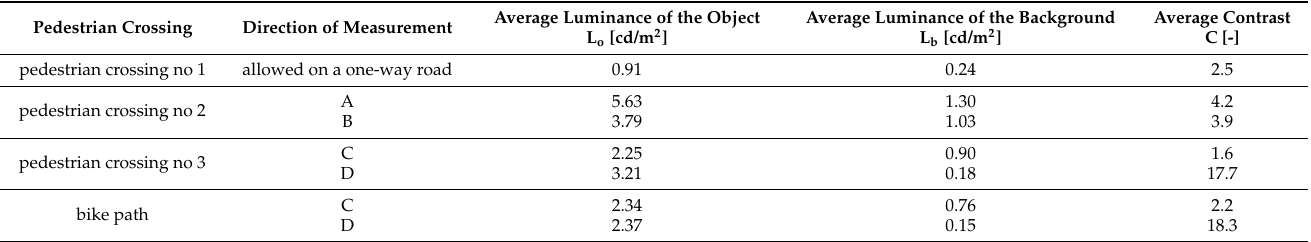
Table 5. Summarizes the results of measurements and